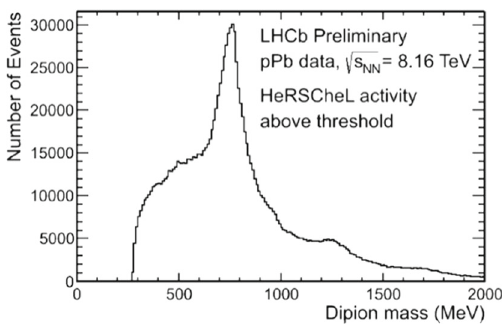
Fig. 4 The differential cross section measured by the ATLAS Collab- oration as function of the dipion invariant mass (Figure taken from Ref. [4])